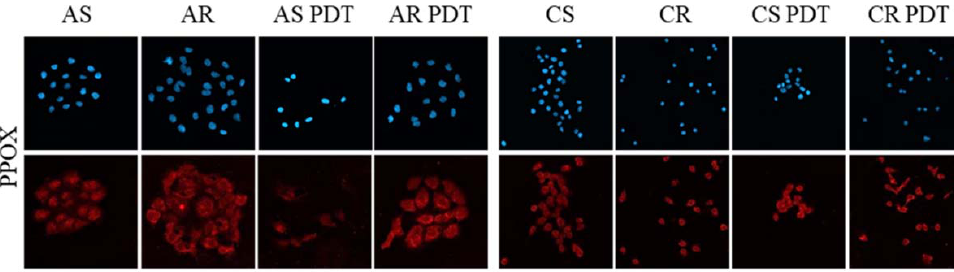
Figure 4. Analysis of the levels of PPOX, FECH, and HO ‐ 1. ( a ) Images of stained cells, before and after PDT treatment. ( b ) Graph with percentage values of corrected total cell fluorescence (CTCF) of untreated, parental cells. ( c ) Graph with percentage values of corrected total cell fluorescence (CTCF) of CAL ‐ 39 cell lines. Asterisks indicate the statistical significance of differences between cells after PDT and untreated control, and between sensitive and resistant cells calculated by Mann– Whitney test (* p ≤ 0.05, ** p ≤ 0.01). 2.4. Protein Profile of PDT ‐ Sensitive and ‐ Resistant Cells For further characterization of PDT ‐ resistant cells, proteomic profiles of parental and resistant cell lines were established by mass spectrometry. The list of identified proteins and their fold change are shown in Tables S1–S5 (Supplementary Materials). Proteins with altered abundance in PDT ‐ resistant cells compared to the sensitive parental cells were grouped by processes in which they participate (Figure 5a). One of the most altered group of proteins was the one that included proteins involved in protein metabolism (Figure 5b).